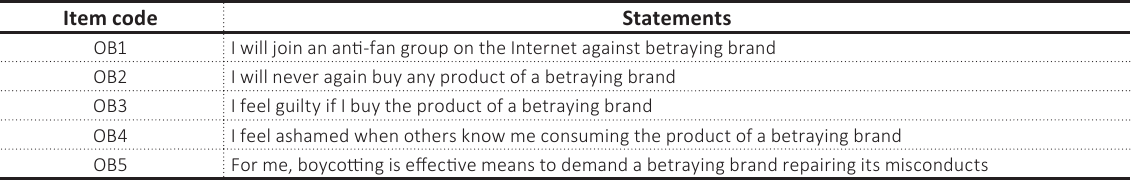
Table A5. Online boycott (OB) Item